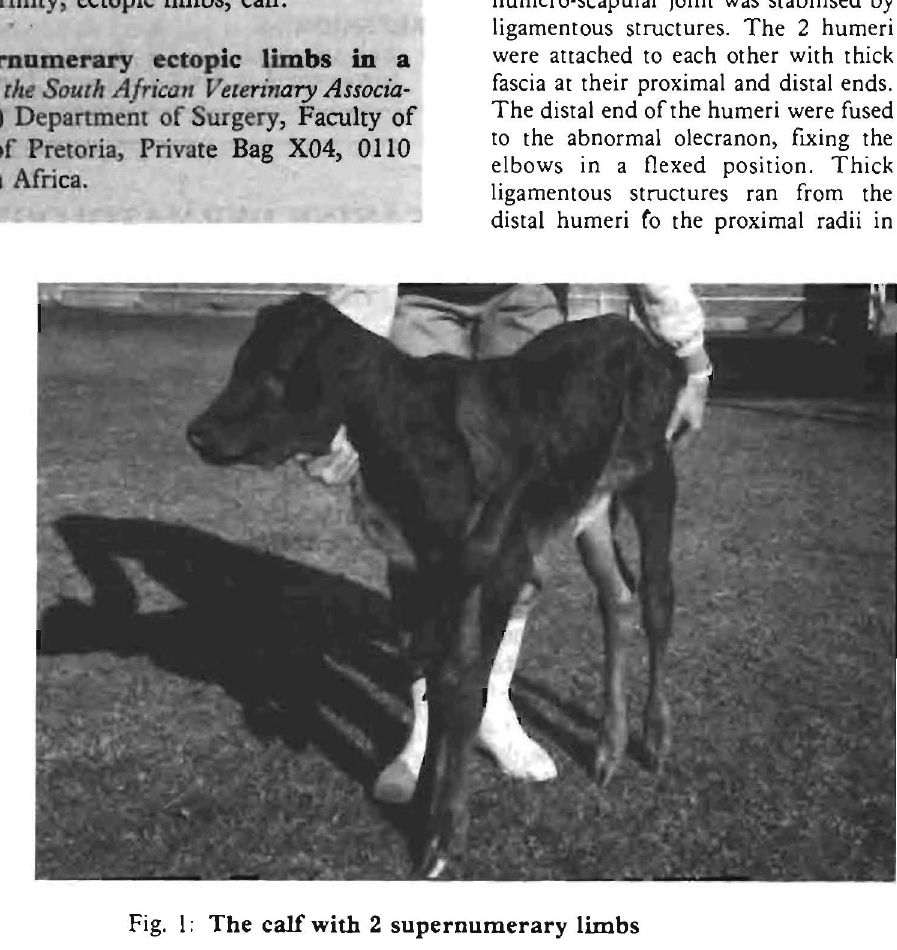
Fig. I: The calf with 2 supernumerary